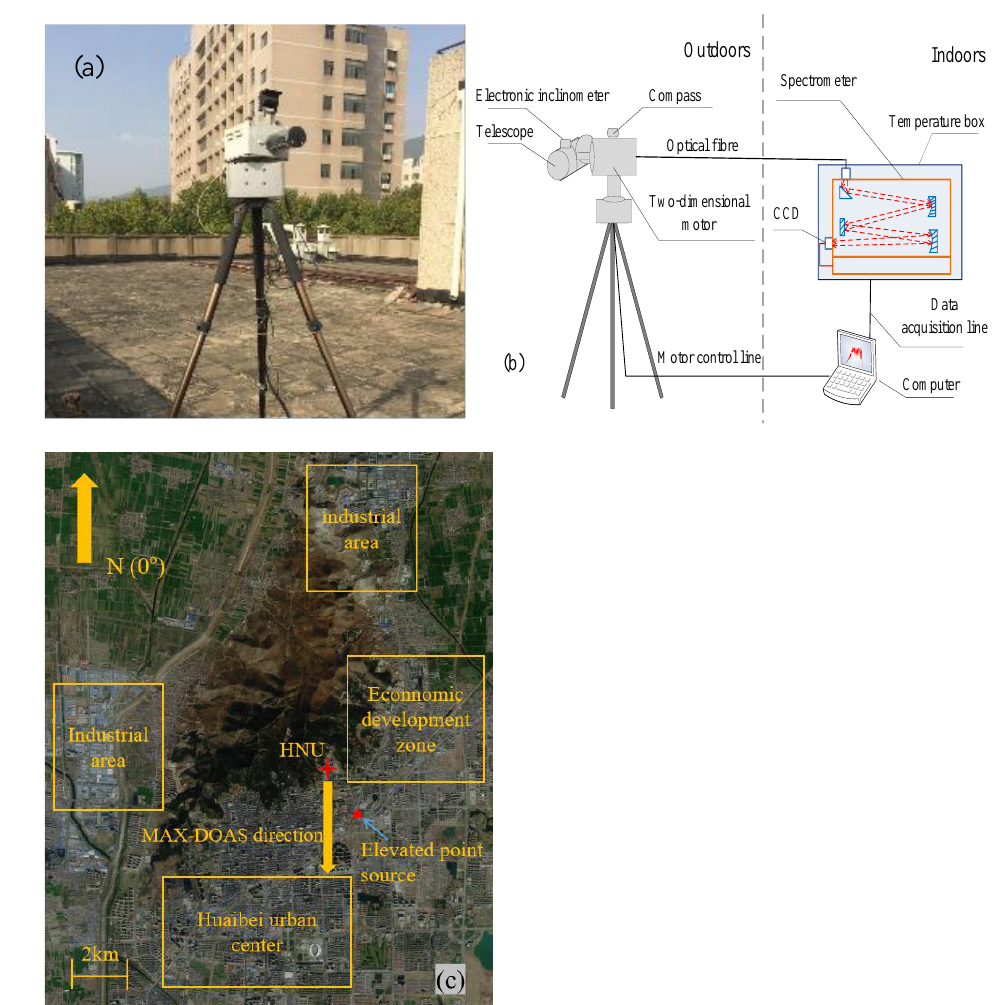
Figure 1. MAX-DOAS observation site at Huaibei Normal University. ( a ) Physical diagram of the system ( b )Schematic diagram of the setup ( c )The location of MAX-DOAS instrument at Huaibei